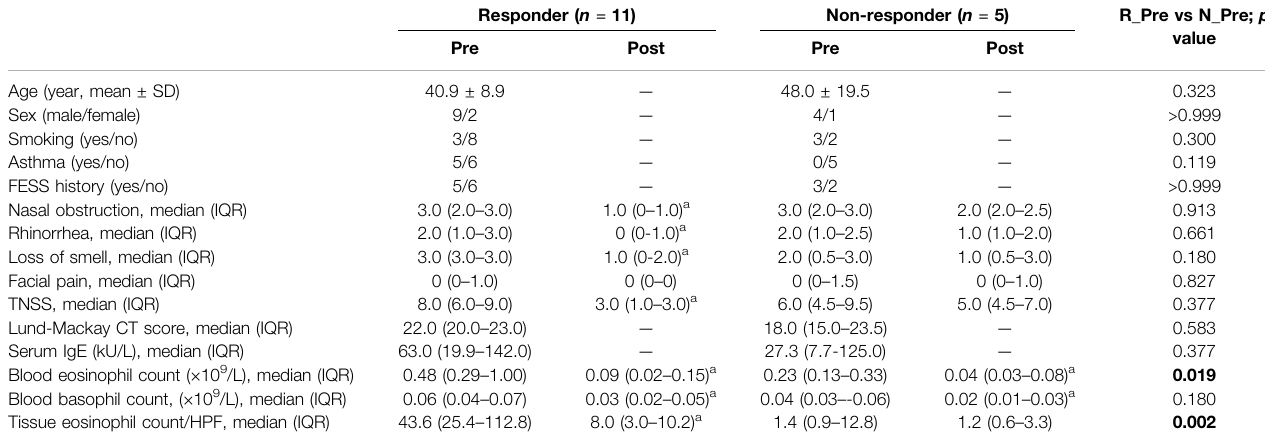
TABLE 1 | Clinical characteristics of GC-responders and